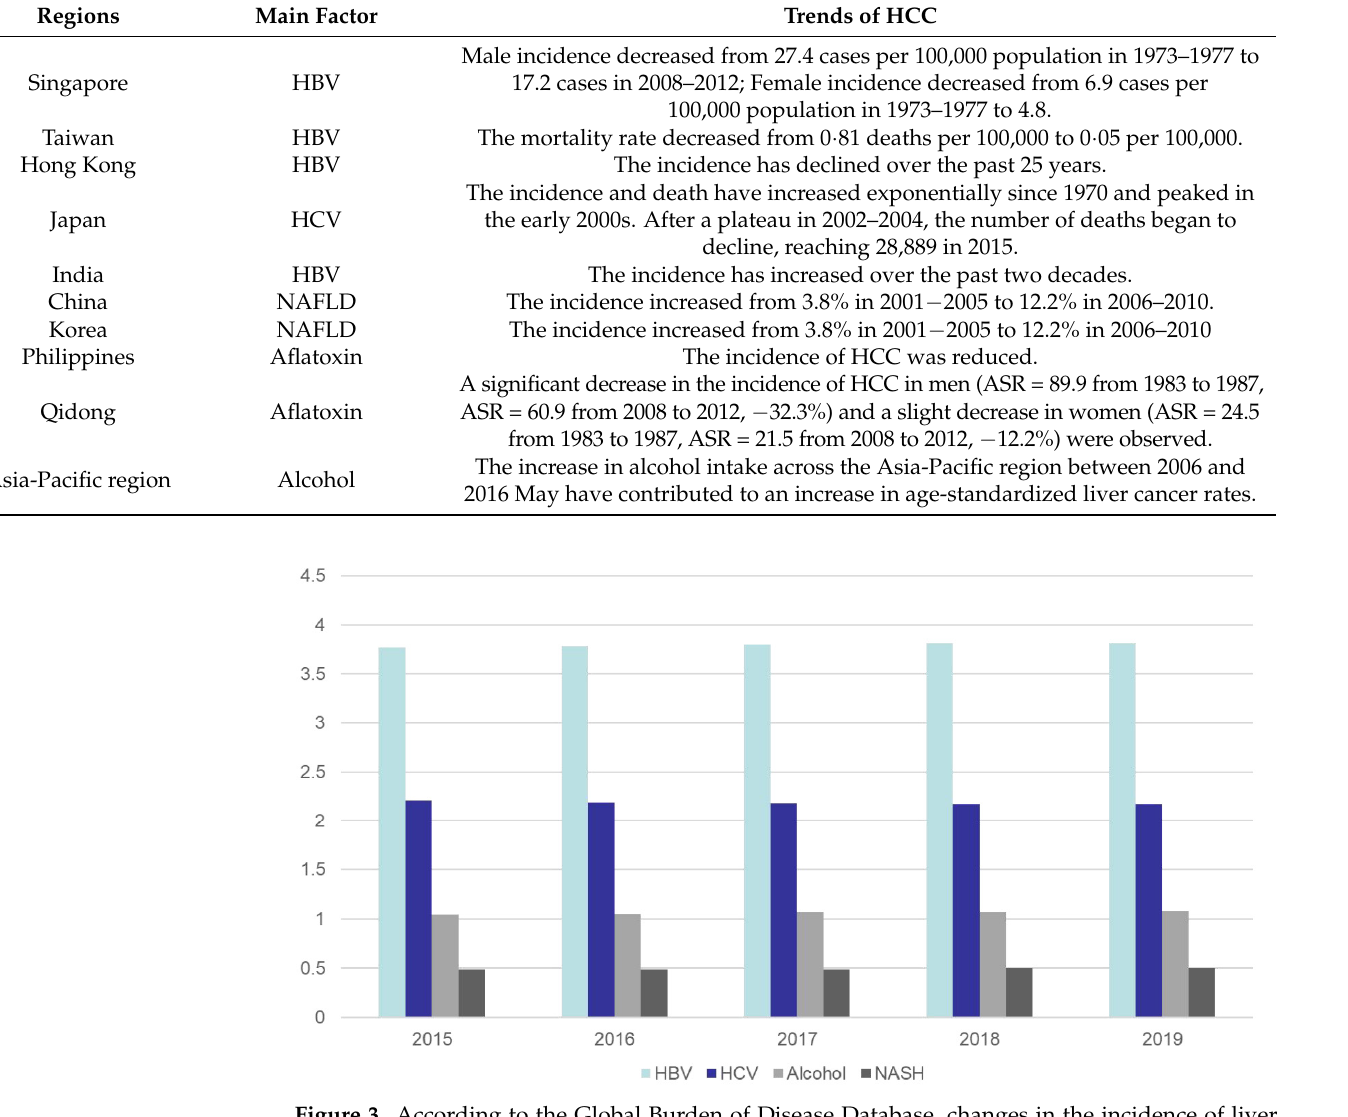
Figure 3. According to the Global Burden of Disease Database, changes in the incidence of liver cancer by different causes in Asia from 2015 to 2019, expressed as rate per 100,000 [5].